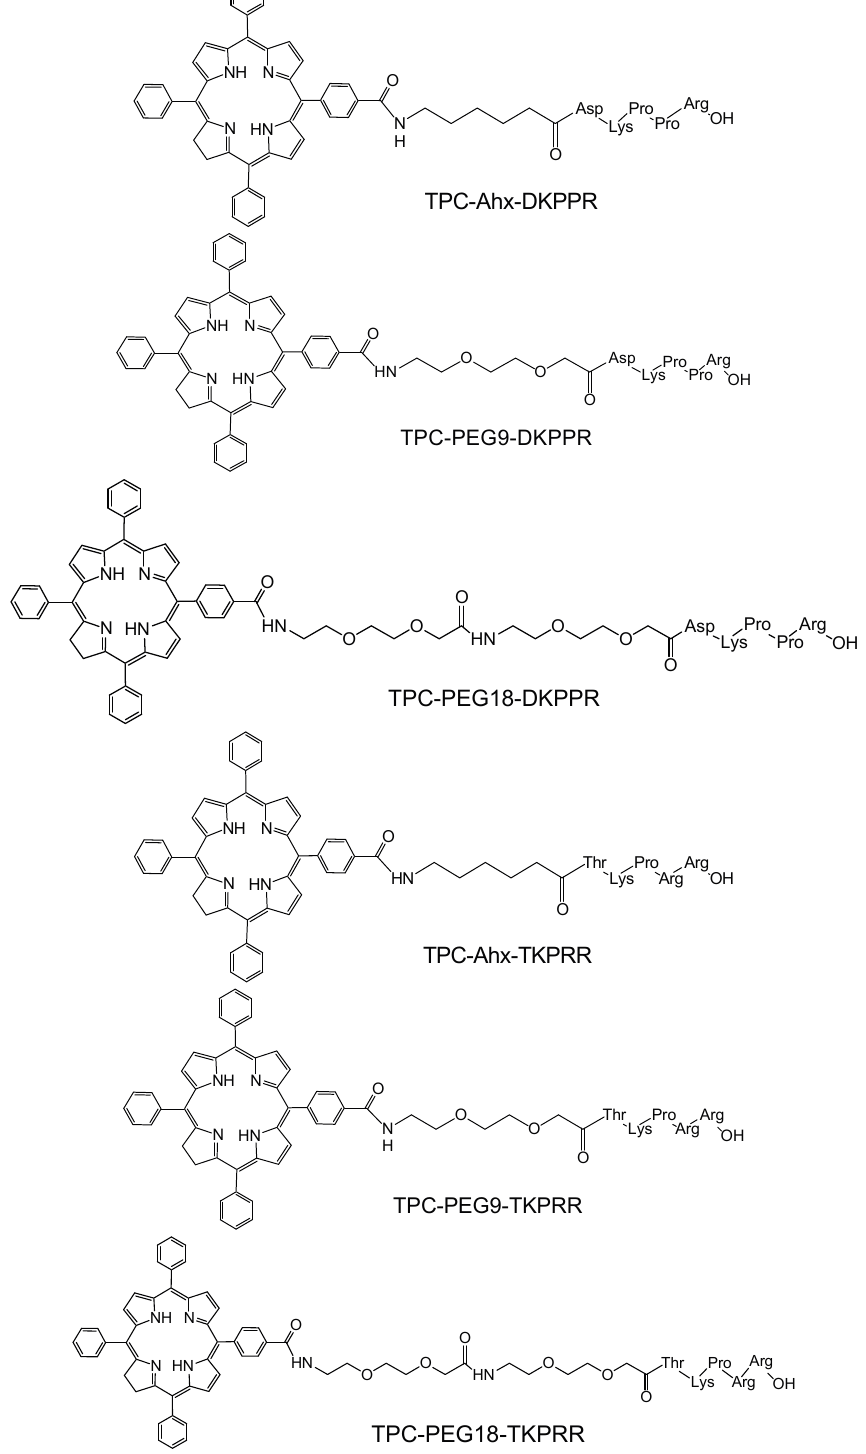
Figure 1. Chemical structures of peptide–spacer–TPC (5-(4-carboxyphenyl)-10,15, 20-triphenyl chlorin)